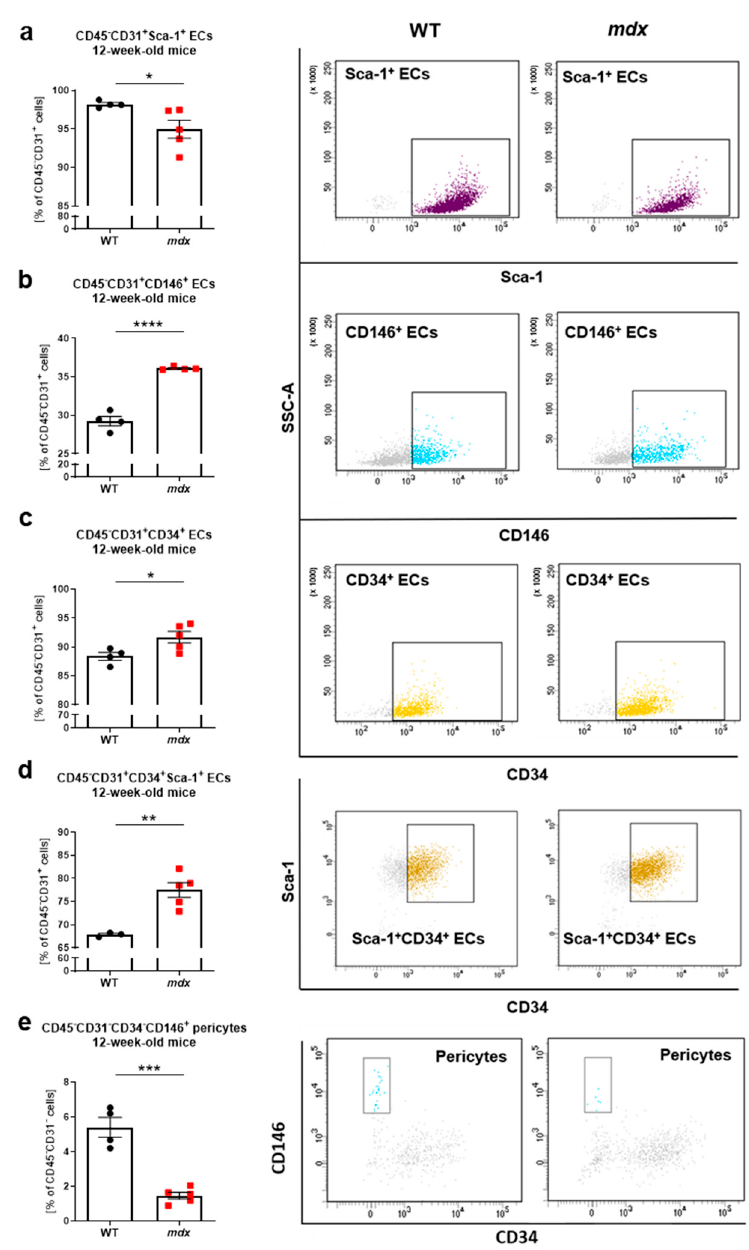
Figure 3. Flow cytometry-based analysis of endothelial cells (ECs) and pericytes in hindlimb muscles of 12-week-old WT and mdx animals. The analysis of subtypes of ECs: ( a ) CD45 − CD31 + Sca-1 + , ( b ) CD45 − CD31 + CD146 + , ( c ) CD45 − CD31 + CD34 + , and ( d ) CD45 − CD31 + CD34 + Sca-1 + of WT and mdx mice. Flow cytometry analysis calculated as a percentage of CD45 − CD31 + cells and representative two-parameters flow cytometry dot plots; n = 4–5/group. ( e ) The number of pericytes identified as CD45 − CD31 − CD34 − CD146 + cells; flow cytometry analysis calculated as the percentage of CD45 − CD31 − cells and representative two-parameters flow cytometry dot plots; n = 4–5/group. The results are presented as mean ± SEM. * p < 0.05, ** p < 0.01, *** p < 0.005, **** p < 0.0001 with unpaired two-tailed Student’s t -test.